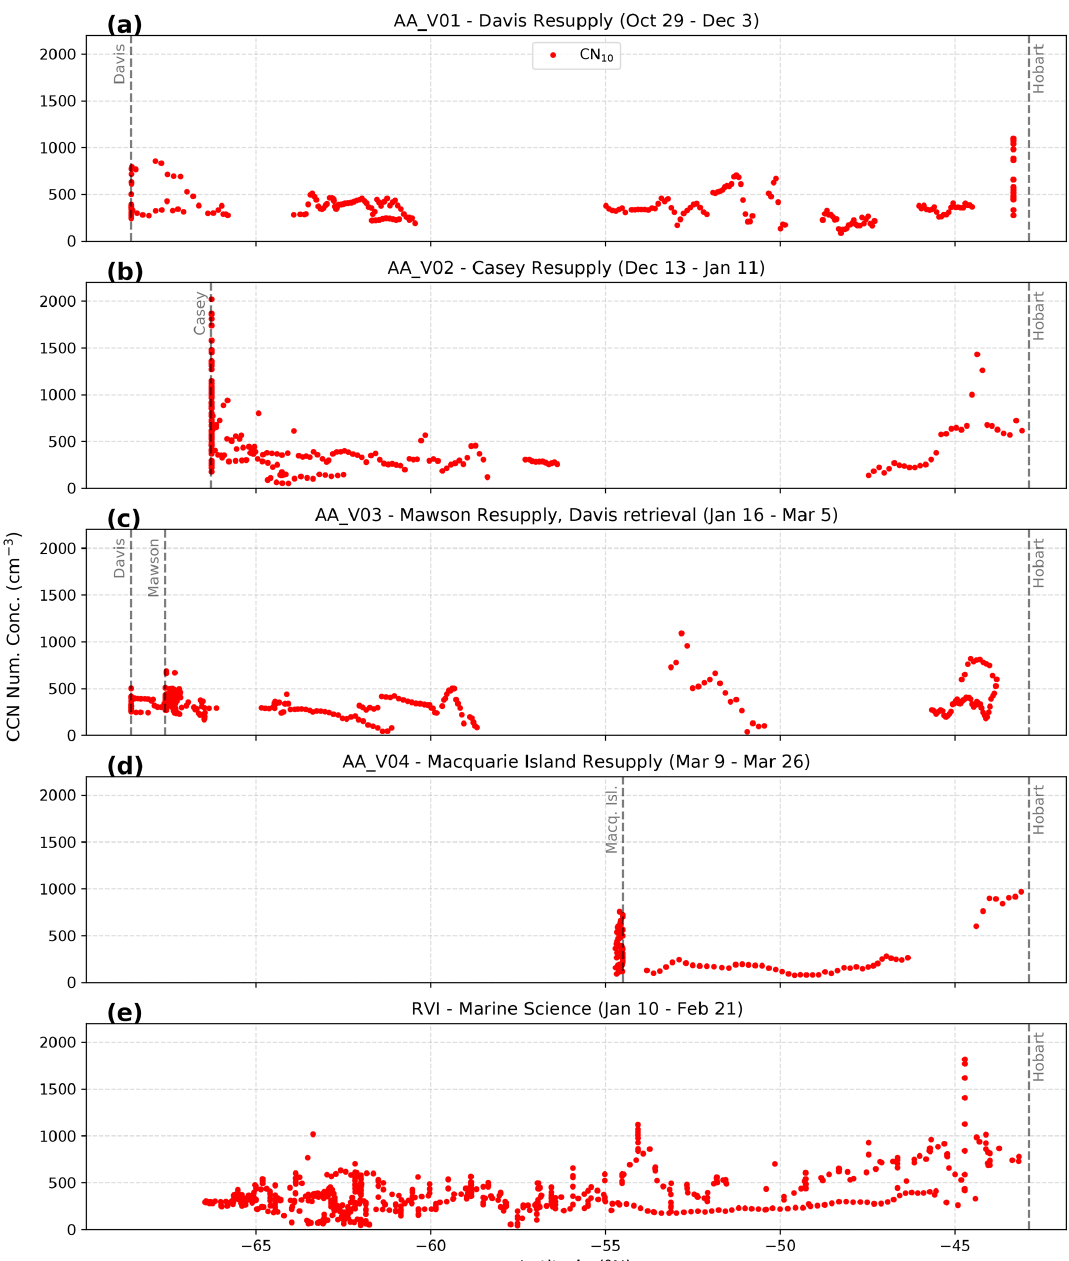
Figure A5. As in Fig. A3 but for CN 10 data.